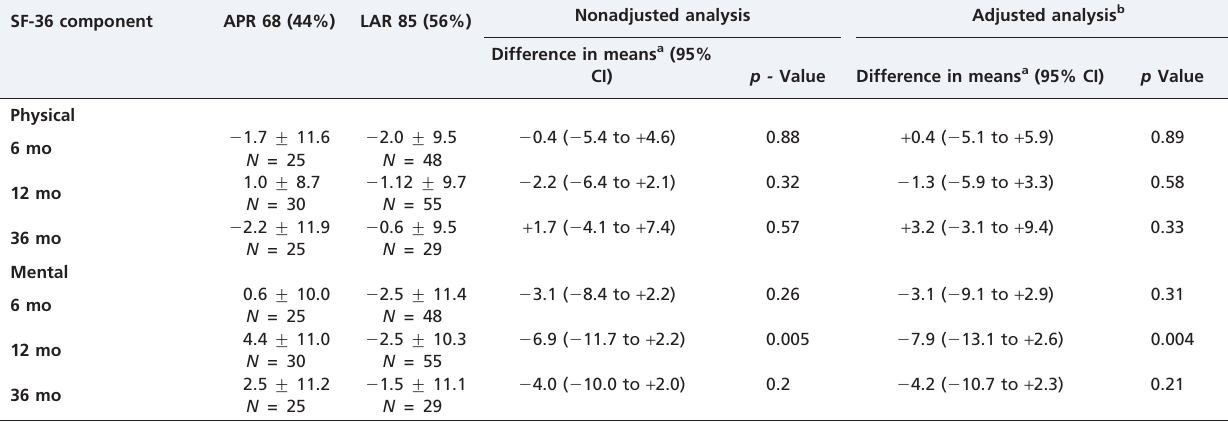
Table 5 - Changes in overall quality of